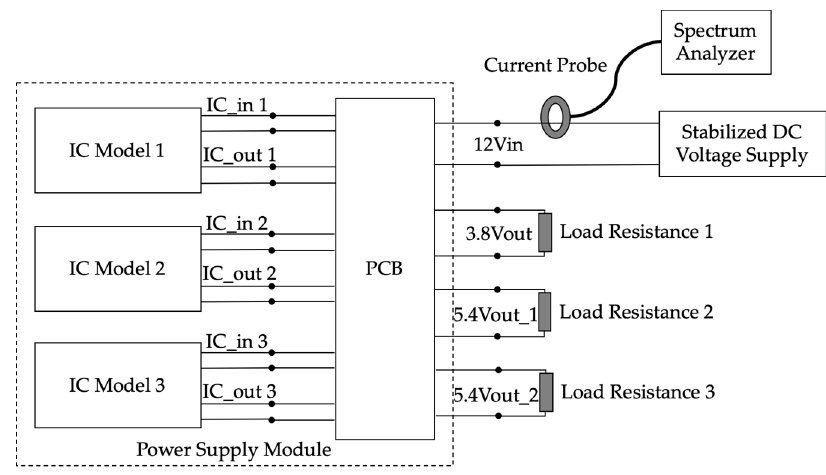
Figure 17. The topology of the power supply module.